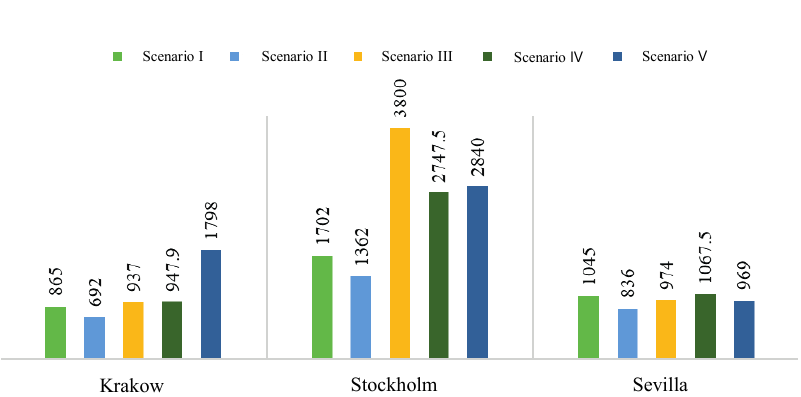
Fig. 6. Annual operating costs of heating and cooling in different